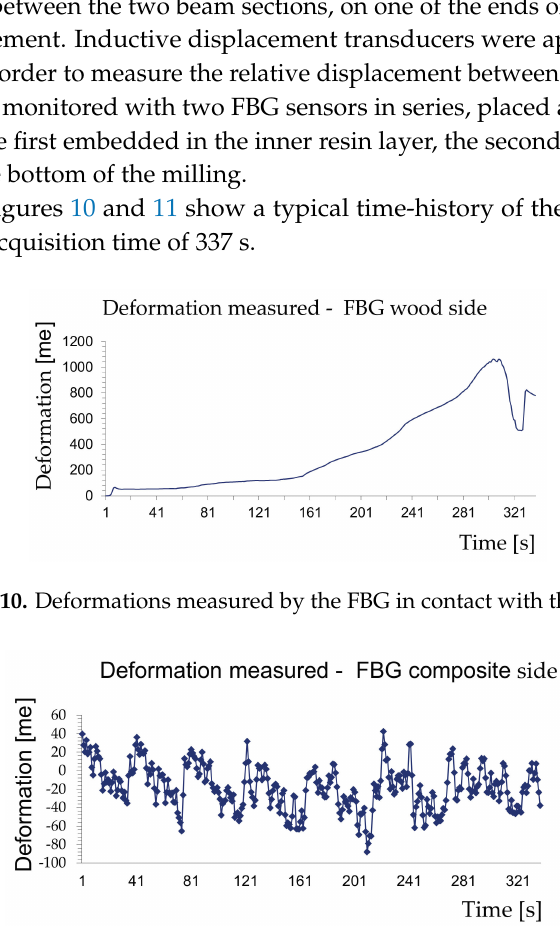
Figure 11. Deformations measured by the FBG in the